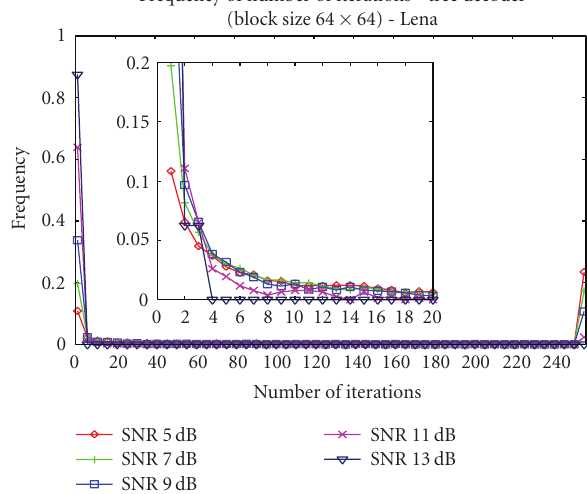
Figure 6: Frequency of number of iterations (tree